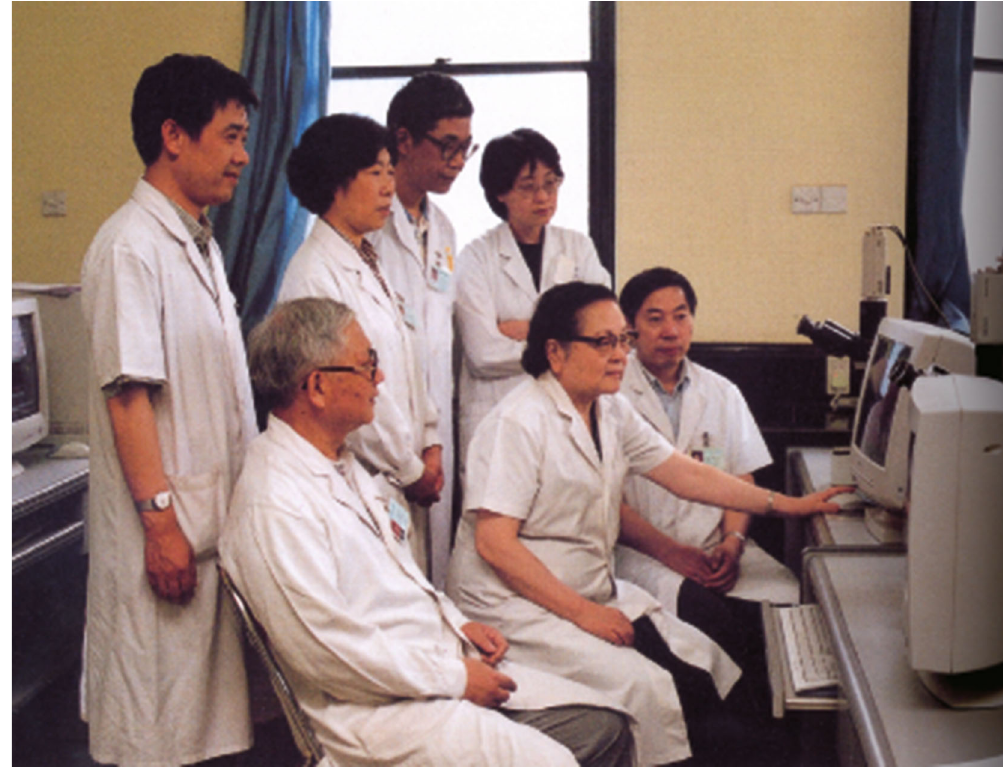
Figure 3. Tonghua Liu and her colleagues from Pathology Department of PUMCH in